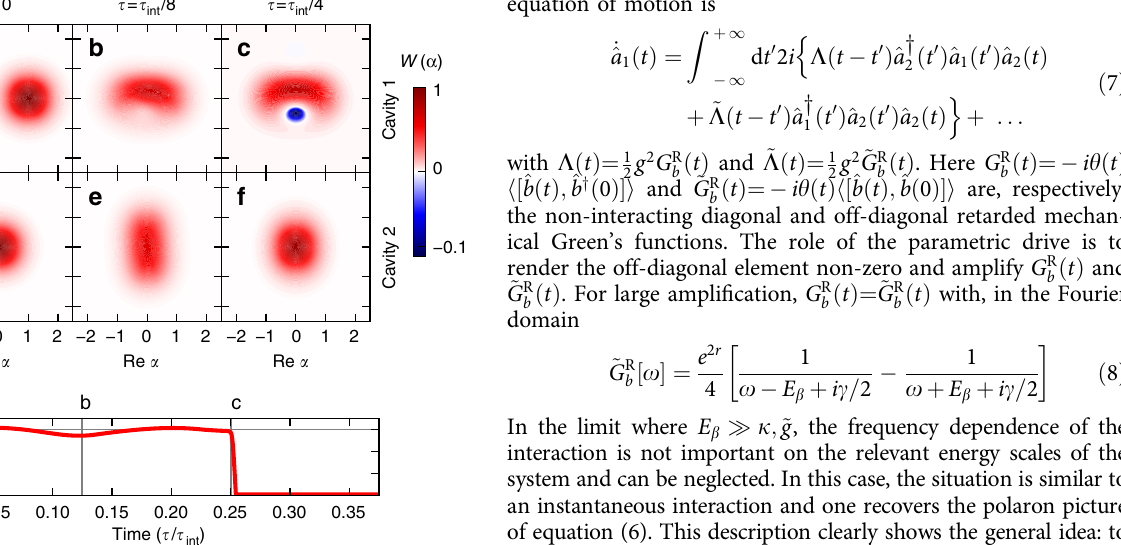
Figure 4 | Emergence of negative photonic Wigner functions from enhanced optomechanical coupling. Results illustrating the pulsed protocol described in the main text, for a mechanical parametric drive yielding the optomechanical interaction ^ H SRP (c.f. equation (2)). The effective photon– photon interaction strength L ¼ ~ g 2 = E b sets the characteristic time t int ¼ 2 p = L . The Wigner function of cavity 1 (2) is plotted in a – c ( d – f ) at three characteristic times. Negative (positive) values of the Wigner functions are plotted in blue (red). ( a , d ) Initial state, where cavity 1 is initially displaced by a 1 ¼ 1, cavity 2 is in vacuum. The parametric drive is then switched on using the transitionless driving scheme with a short turn- on time t on ¼ t int = 400 and a Gaussian profile for r ( t ). The corresponding mechanical amplification strength is plotted in g , where a, b and c refer respectively to t ¼ 0 ; t ¼ t int = 8and t ¼ t int = 4. ( c ) Negativity in the cavity-1 Wigner function is maximal at t ¼ t int /4. As discussed in the main text (and shown in g ), the parametric drive can then be turned off with the TD scheme, and the cavity-1 state will be emitted into the cavity-1 input–output waveguide, resulting in a propagating photonic state with a negative Wigner function. ( g ) The MR stays in a squeezed state when the parametric drive is on t on o t o t int = 4 ð Þ . Parameters here are g ¼ 0.3 k , mechanical damping g ¼ 10 (cid:2) 4 k and mechanical bath occupancy (cid:2) n th the parametric-drive strength and detuning are chosen to yield an amplification factor e 2 r ¼ 30dB and E b ¼ 2 ~ g . The resulting Kerr-interaction strength is then L E 2.4 k and the rate at which the mechanical noise heats the cavities is G (cid:7) k = 40. If one reduces the amplification factor to 25dB, the negativity is lost; this highlights the crucial role of the parametric